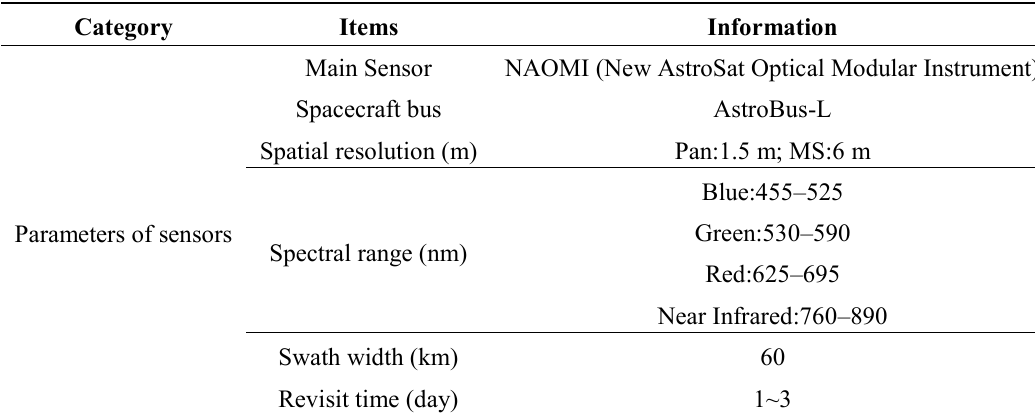
Table 1. Specifications of SPOT-6